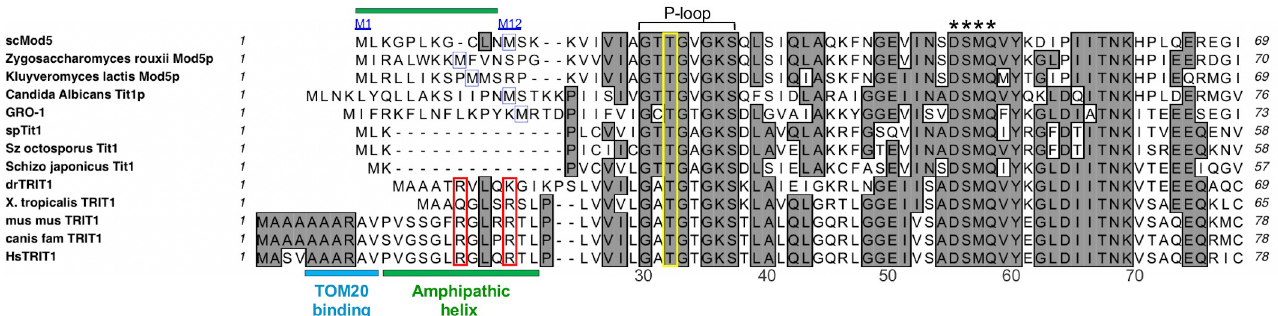
Fig 1. N-termini sequence alignment of representatives of phylogenetic groups of IPTases. Sequences of the N-termini of IPTases. scMod5: Saccharomyces cerevisiae ; GRO-1: IPTase from C . elegans ; spTit1: Schizosaccharomyces (Sz) pombe ; Sz octosporus ; Sz japonicus ; drTRIT1: D . rerio : Danio rerio; mus mus : Mus musculus; canis fam : Canis familiaris; X . tropicalis : Xenopus tropicalis; Hs : Homo sapiens . Numerals below the alignment show human amino acid numbering. The region between M1 and M12 of Mod5 that is required for mitochondrial targeting is indicated by a green rectangle above [34, 35]. The second methionines that may be used as alternative translation start sites for cytoplasmic localization are boxed in blue. The invariant Threonine within the conserved P-loop that functions in catalysis is in the yellow rectangle. Asterisks indicate the conserved DSMQ sequence that forms a network of contacts that mediate A37 recognition; the D of which acts as a general base for catalysis [24] and the M of which is M57 of TRIT1(57–467). As predicted by MitoFates [53], the TOM20-binding site of human TRIT1 is underlined with a blue bar and the amphipathic helix of TRIT1 and Mod5 are indicated with green bars. The two key basic residues in the conserved amphipathic helix of mammalian MTS that were mutated in human TRIT1 are in red rectangles.